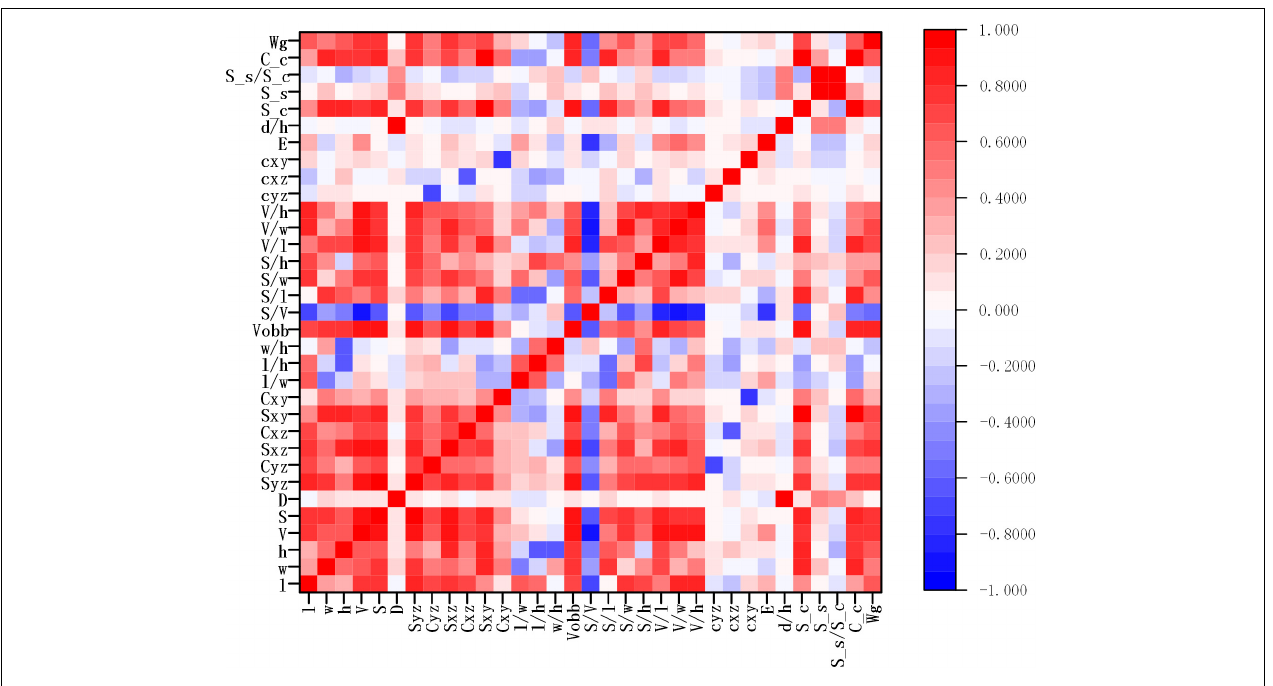
FIGURE 9 | The result of wheat grain traits correlation analysis.